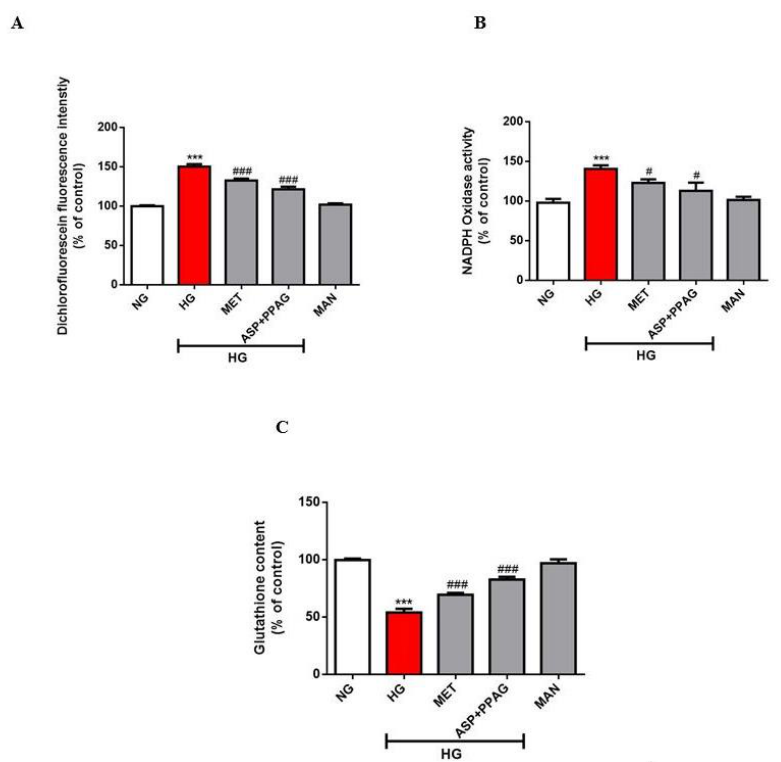
Figure 4. The combination effect of aspalathin (ASP) and phenylpyruvic acid-2- O -β- D -glucoside (PPAG) in comparison to metformin (MET) on ameliorating oxidative stress markers. This was done by measuring dichlorofluorescein intensity ( A ) to estimate productions of reactive oxygen species, NADPH oxidase activity ( B ) and glutathione content ( C ). H9c2 cardiomyocytes were exposed to 33 mM glucose (HG) for 48 h before treatment with a combination of ASP and PPAG, as well as MET, at a dose 1 µ M for 6 h. Mannitol (MAN) at a concentration of 33 mM was used to rule out the e ff ect of osmolarity. Results are expressed as the mean ± SEM of three independent experiments relative to the normal glucose (NG) control (5.5 mM). *** p < 0.001 versus NG control; # p < 0.05, ### p < 0.001 versus HG control.